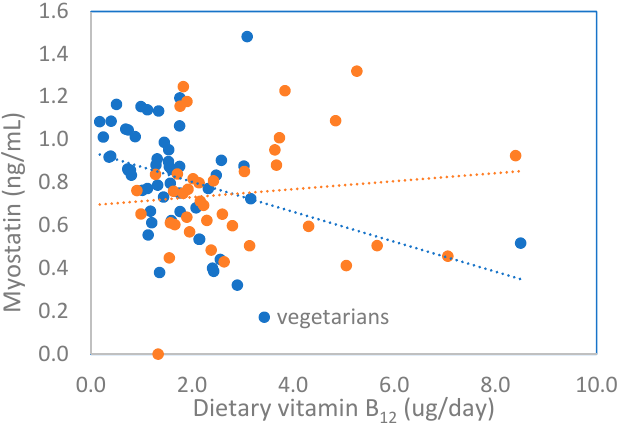
Figure 1. Scatter plot of theoretical myostatin estimated from regression model (Table 5) versus dietary vitamin B 12 in vegetarian and omnivorous children.